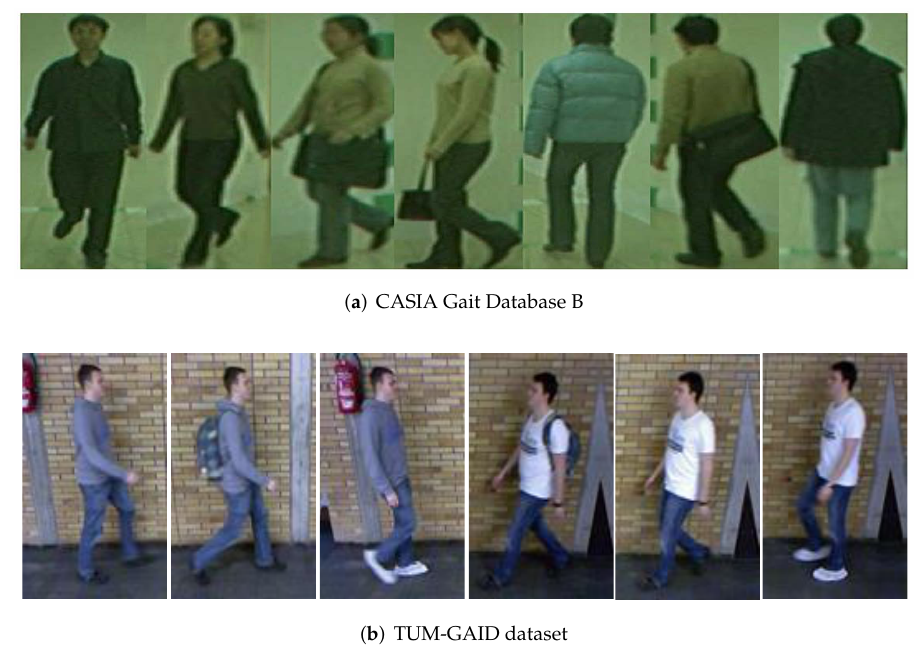
Figure 5. Experimental Datasets ( a ) CASIA Gait Database B include samples under different view angles and states. ( b ) The left three images are captured earlier months than the right. The person has been recorded twice in different conditions in the TUM-GAID dataset. Table 1. Experimental data settings on CASIA Gait Database B and TUM-GAID